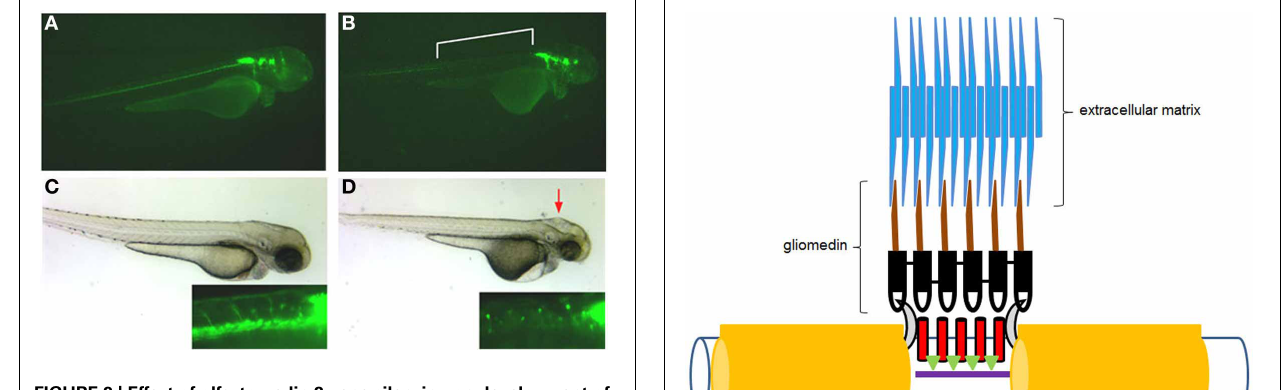
FIGURE 3 | Effect of olfactomedin 2 gene silencing on development of the nervous system in zebrafish. Panels (A,C) show a 54hpf normal embryo injected with a control morpholino-oligonucleotide that expresses GFP under the control of the Islet-1 promoter labeling the spinal cord and cranial nuclei. The inset in panel (C) shows axonal projections from spinal cord motor neurons and neatly aligned cell bodies of Rohon-Beard neurons. Panels (B) and (D) show embryos at the same stage injected with 5ng of a morpholino-oligonucleotide that silences expression of the zebrafish olfactomedin 2 gene. Note the complete absence of anterior spinal cord motor neurons [bracketed area in panel (B) and inset in panel (D) ] and jumbled locations of cell bodies of the Rohon-Beard neurons [inset in panel (D) ]. Deformations of the head are also evident (red arrow). See also Lee et al. (2008).